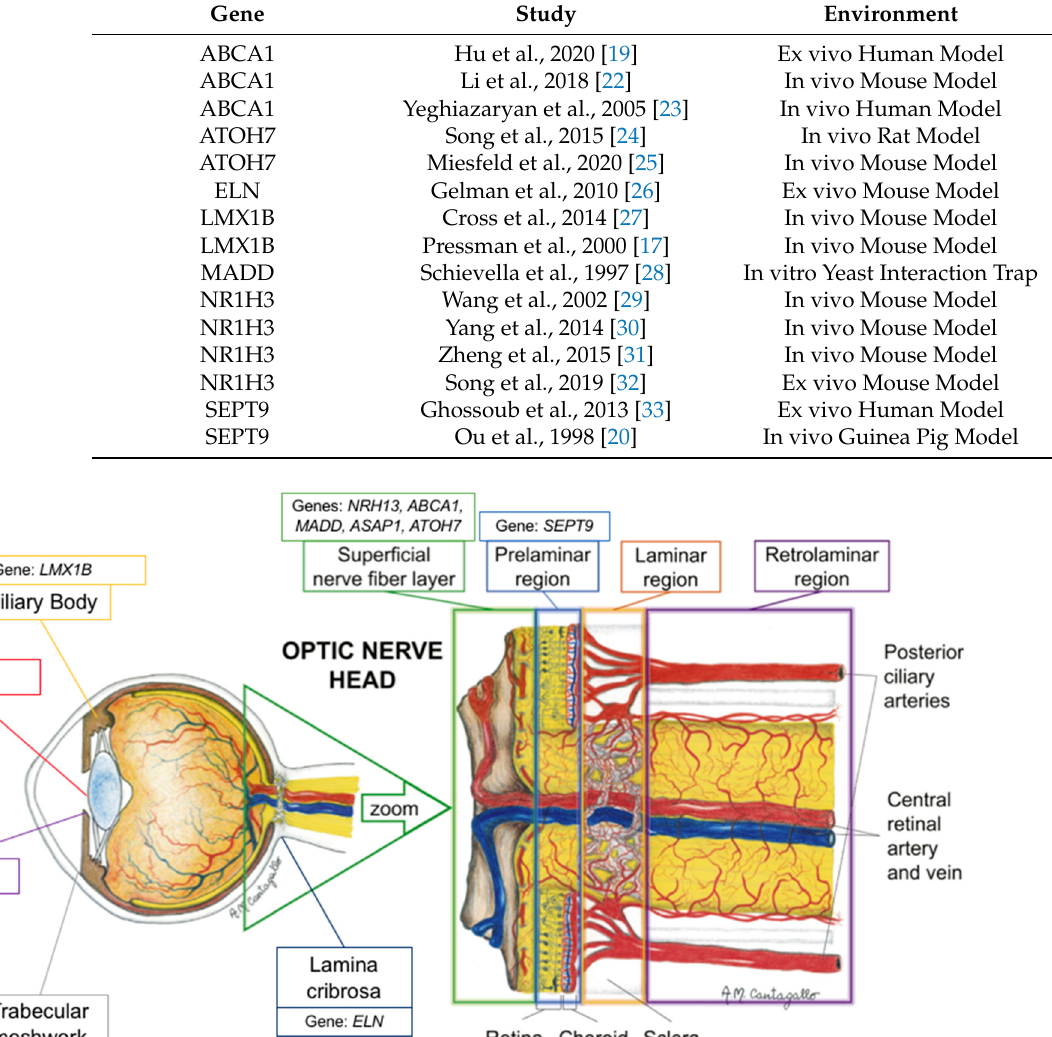
Table 2. List of IOP and POAG genes under investigation.